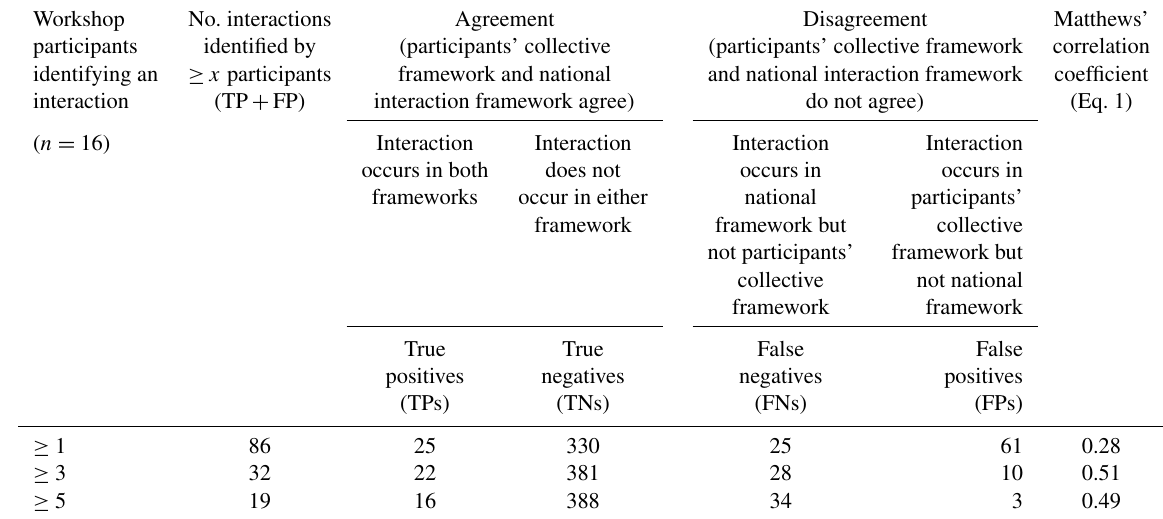
Table 7. Calculation of Matthews’ correlation coefficient (MCC) to assess agreement between the collective knowledge of 16 workshop participants (Fig. 2) and national interaction framework (Fig. 3). Three different thresholds, each relating to the number of workshop par- ticipants (out of 16) identifying a particular interaction, are used to determine collective knowledge of hazard interactions. The number of “agreements” and “disagreements” between the workshop participants’ response and national interaction framework (see column headers for descriptions) is shown. For each row, the sum of true positives (TPs) and false negatives (FNs) is 50, and the sum of true negatives (TNs) and false positives (FPs) is 392. MCC values are determined using Eq. (1). MCC =+ 1 . 0 means complete agreement; MCC =− 1 . 0 means complete